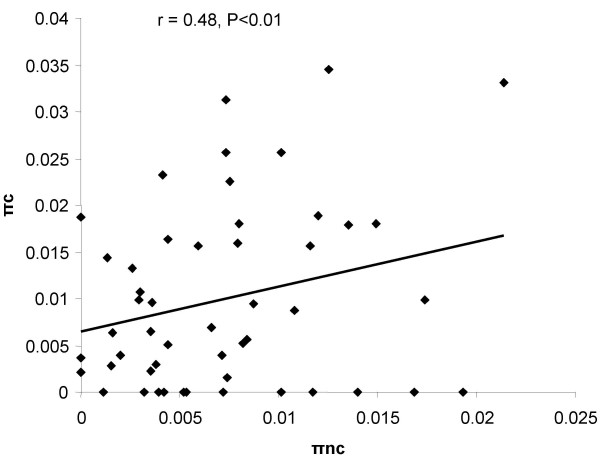
Correlation of nucleotide diversity in coding (πc) and non-coding regions (πnc) πc: nucleotide diversity of coding region, πnc: nucleotide diversity of non-coding region.